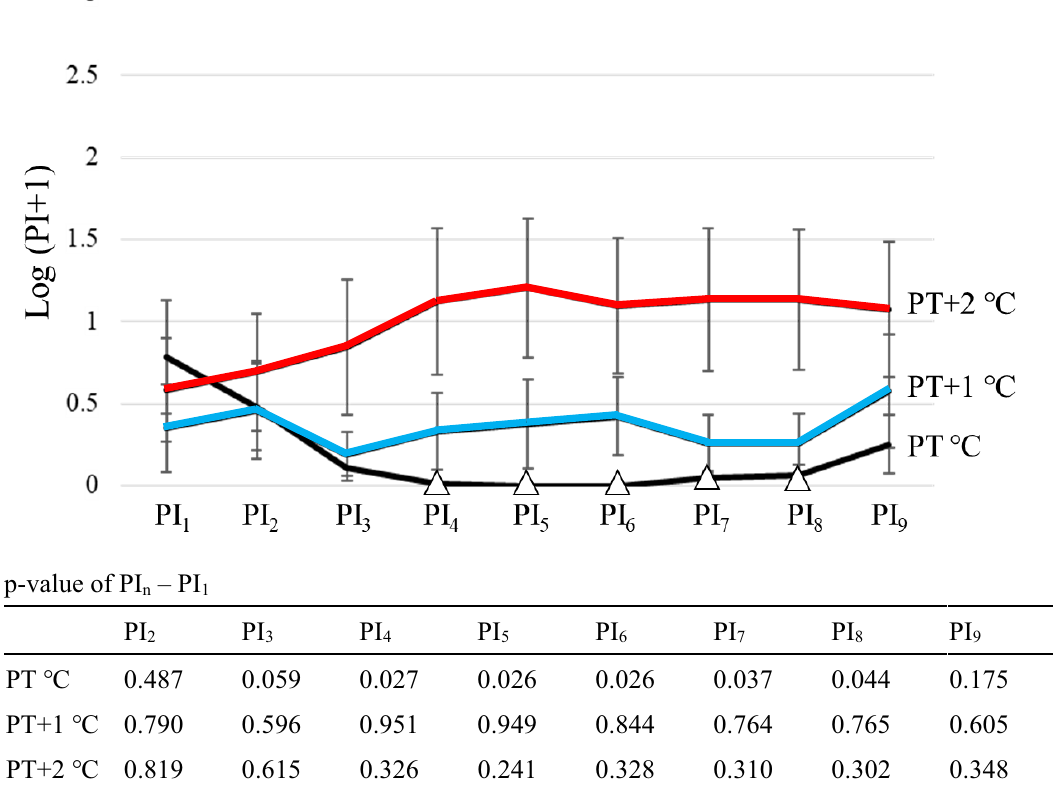
Healthy volunteers with no pain n =